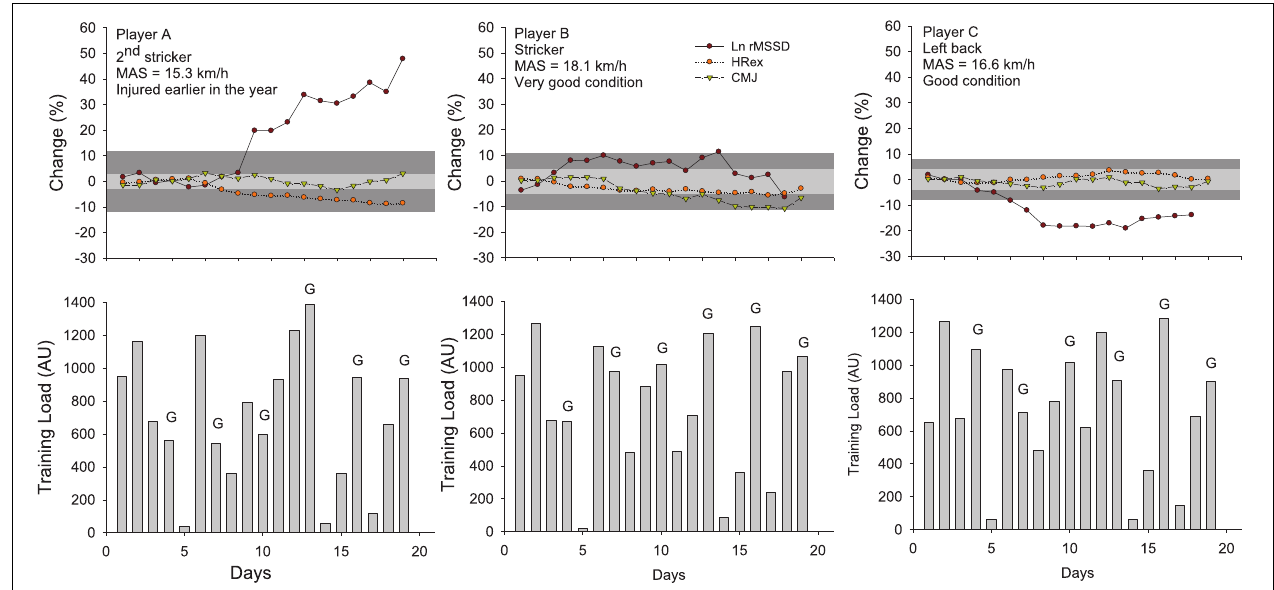
FIGURE 6 | Changesinthelogarithmofthesquarerootofthemeanofthe sum of the squares of differences between adjacent normal R-R intervals measured after exercise (Ln rMSSD), submaximal exercise heart rate (HRex), counter movement jump height (CMJ) and training load (session-rate of perceived exertion load × training/match duration Impellizzeri et al., 2004) in three highly-trained young soccer players during a competitive training camp. The gray areas represent trivial changes (See Table 2 ) for HRex and CMJ (light gray) and HRV (dark gray). Errors bars (typical error of measurement, see Figure 7 ) have been omitted for clarity. WhilethismightnotbethatclearwhenconsideringtheactualspreadoftheTE, any change that is outside the gray areas is considered here as substantial (section Interpreting Changes in Heart Rate Measures: “Statistics are our weapons”). The changes in these variables in the three different players show different scenarios and illustrate how these indices can be used in combination to infer on training status and adaptations. Player A likely showed a positive adaptation to the camp (decrease in HRex and increasein Ln rMSSD), probably related to the fact that he arrived fresh and was a little bit detrained at the start